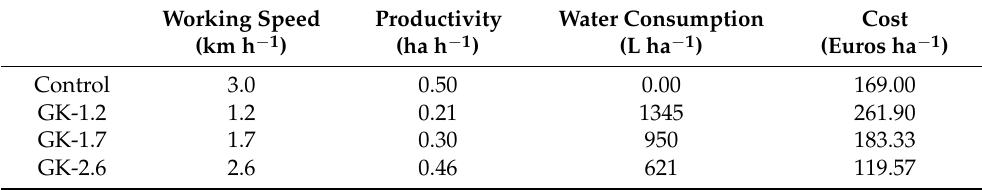
Table 6. Cost–benefit analysis of the two tested weed control practices. GK-1.2, GK-1.7 and GK-2.6 indicate the Grass Killer treatments at 1.2, 1.7 and 2.6 km per hour working speeds, respectively. Control = hoeing